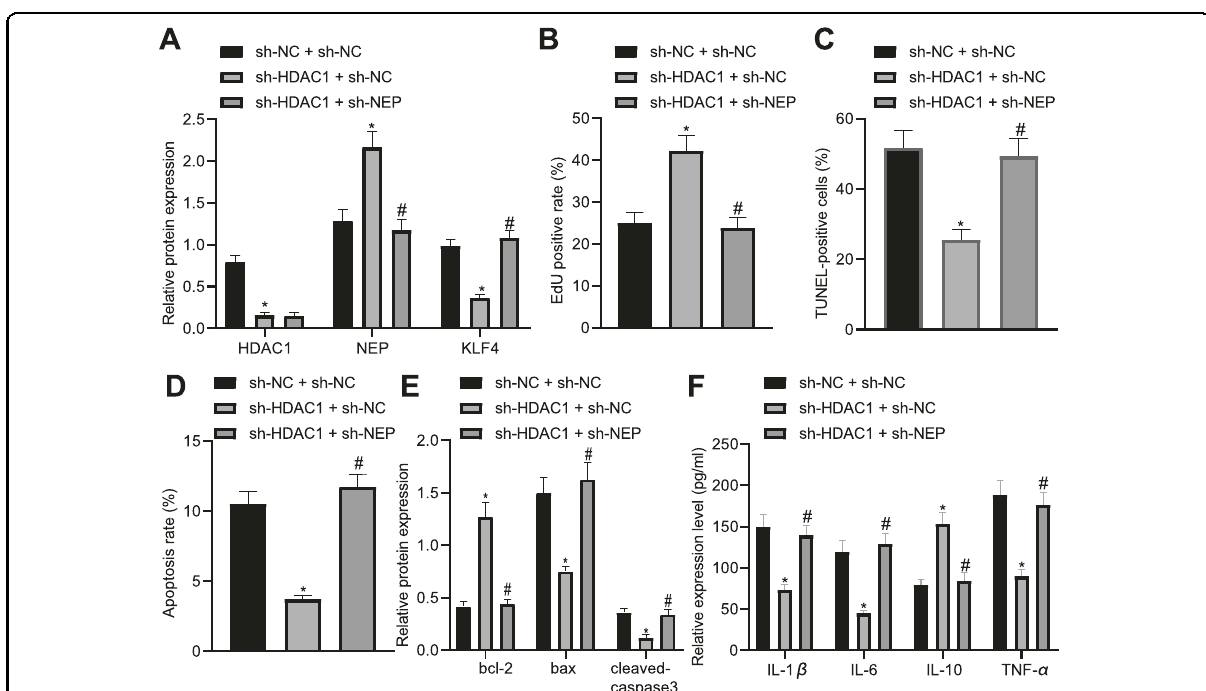
Fig. 6 Downregulation of HDAC1 inhibits KLF4 expression by upregulating NEP expression thus promoting pancreatic acinar cell proliferation. A Western blot analysis was performed to detect HDAC1, NEP, and ATF4. B EdU was applied to detect pancreatic acinar cell proliferation after sh-HDAC1 or sh-NEP treatment. C TUNEL was performed to detect pancreatic acinar cell apoptosis after sh-HDAC1 or sh-NEP treatment. D Flow cytometry was performed to detect pancreatic acinar cell apoptosis after sh-HDAC1 or sh-NEP treatment. E Western blot analysis was performed to detect expression of Bcl-2, Bax, and cleaved-caspase3. F ELISA was conducted to test levels of IL-1 β , IL-6, TNF- α , and IL-10. * p < 0.05 compared with the sh-NC + oe-NC group; # p < 0.05 com p ared with the sh-HDAC1 + oe-NC group. The comparison of the measurement data (mean standard±deviation) among multiple groups was analyzed by one-way analysis of variance with Tukey ’ s post hoc